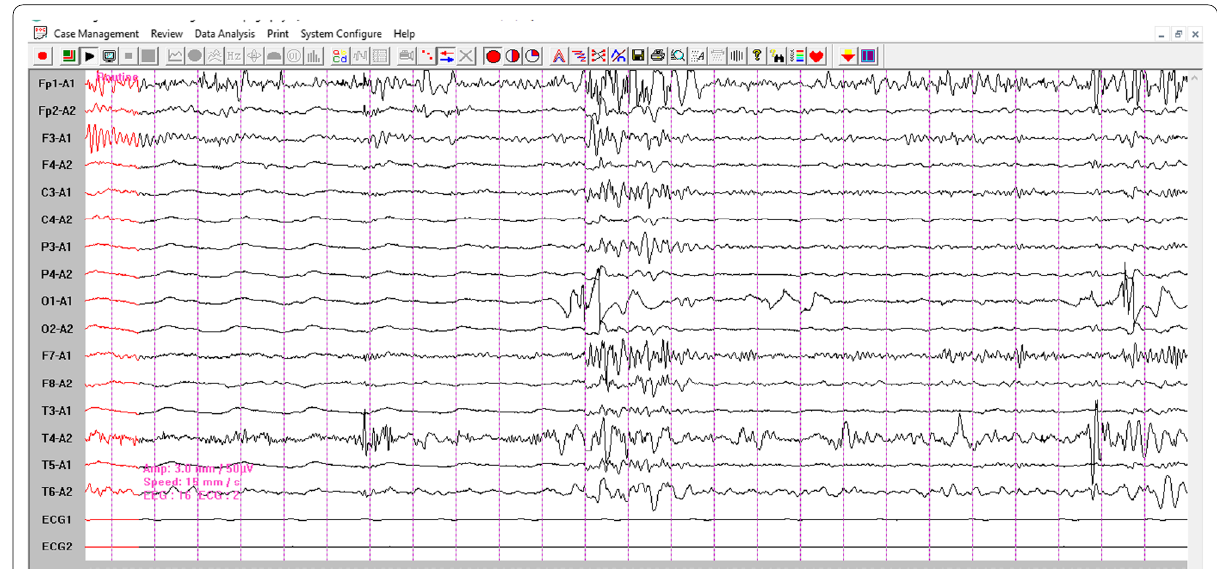
Fig. 5 8-year-old child, seen for progressive intellectual deterioration and epileptic